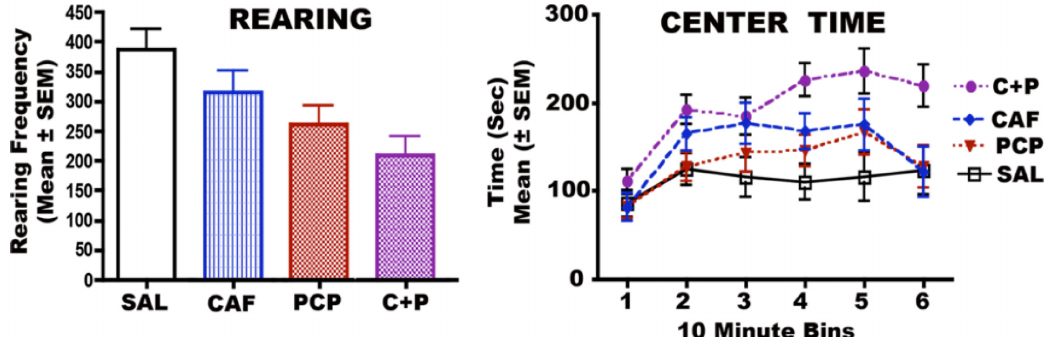
Figure 9. Frequency of Rearing and Time Spent at Center versus Edges of Chamber.